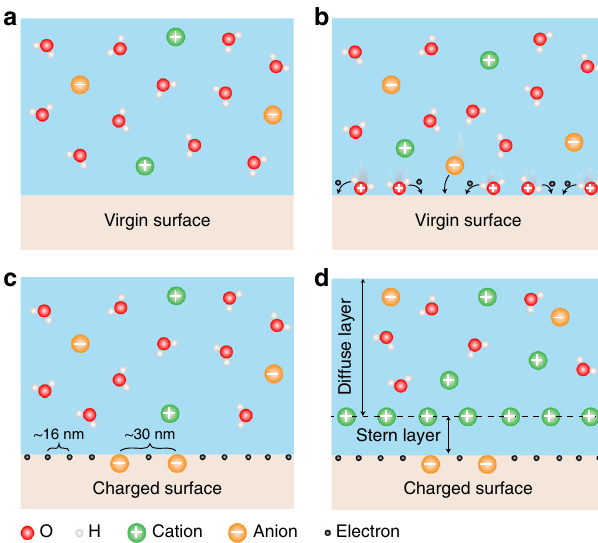
Fig. 4 Mechanism of liquid – solid CE and formation of electric double- layer. a The liquid contacts a virgin surface (before CE). b The water molecules and ions in the liquid impact the virgin surface and electron transfer between the water and the surface. c The surface is charged and the charge carriers are mainly electrons (WCA > 90°, pH = 7), some ions may be generated on the surface caused by the ionization reaction etc. d The opposite polarity ions are attracted to migrate toward the charged surface by the Coulomb force, electrically screening the fi rst charged